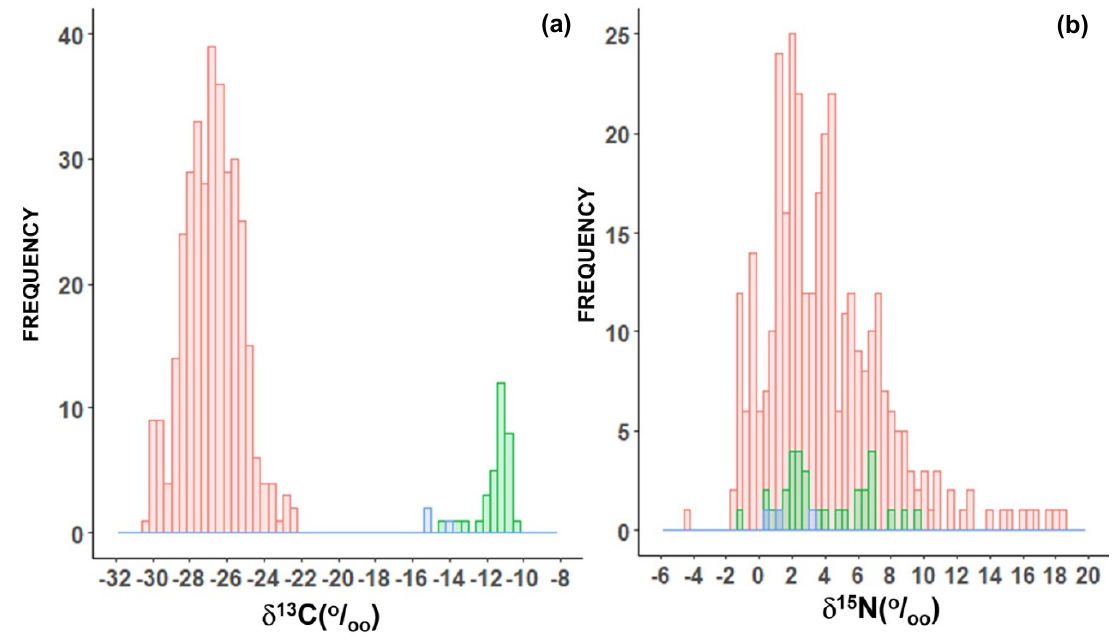
Figure 1. Frequency histogram of δ 13 C ( a ) and δ 15 N ( b ) of in natura plants used as food in Brazil. green bars represent C 4 plants, the blue bars represent CAM plants, and the red bars represent C 3 plants.